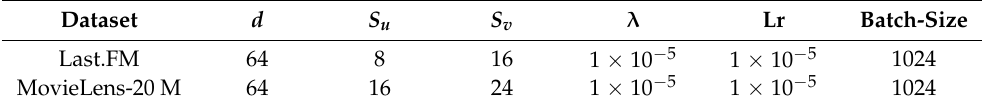
Table 2. Experimental parameter